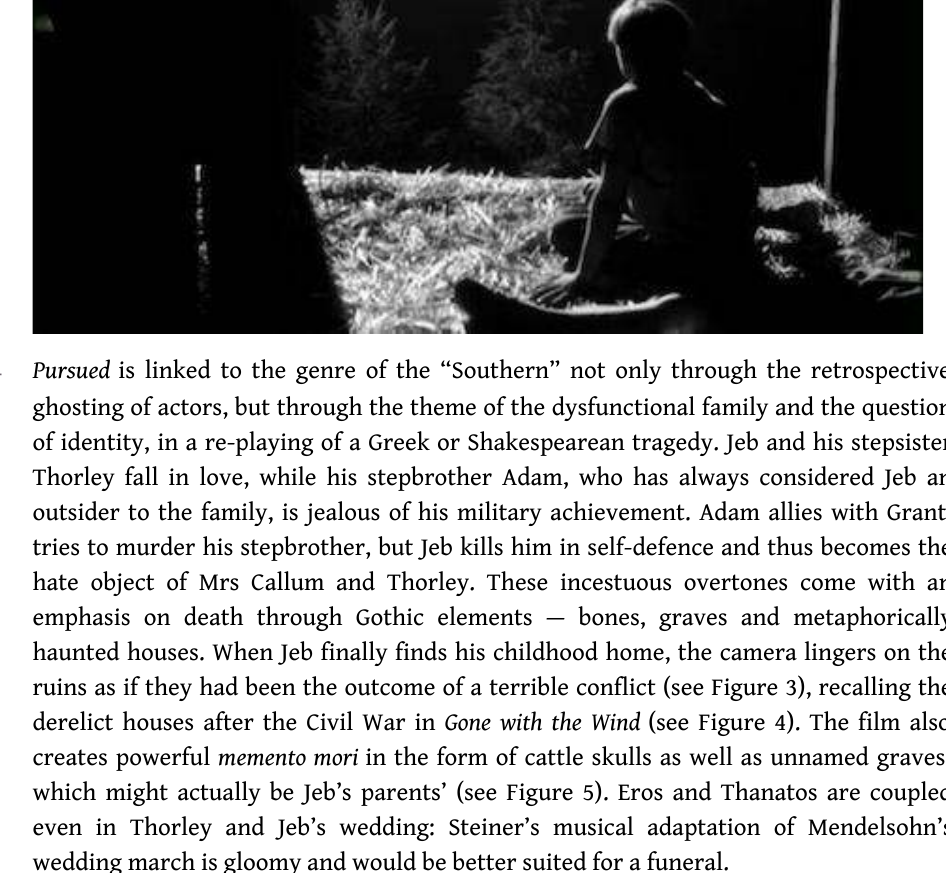
Figure 3: The ruins in Pursued